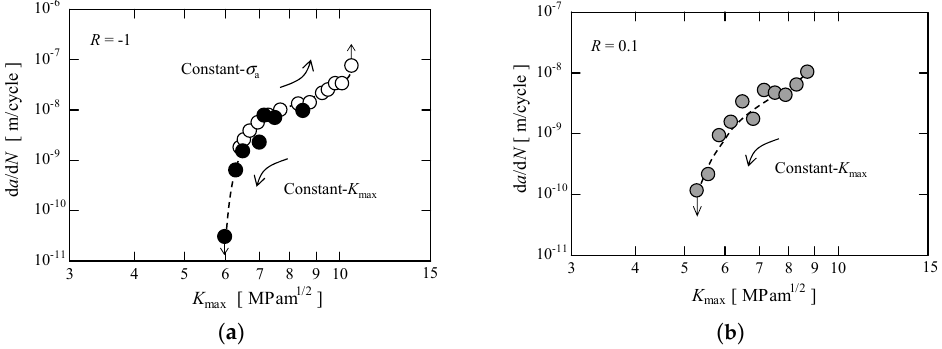
Figure 8 . Relations between d a /d N and K max for short surface fatigue cracks; ( a ) R = − 1; ( b ) R = 0.1.